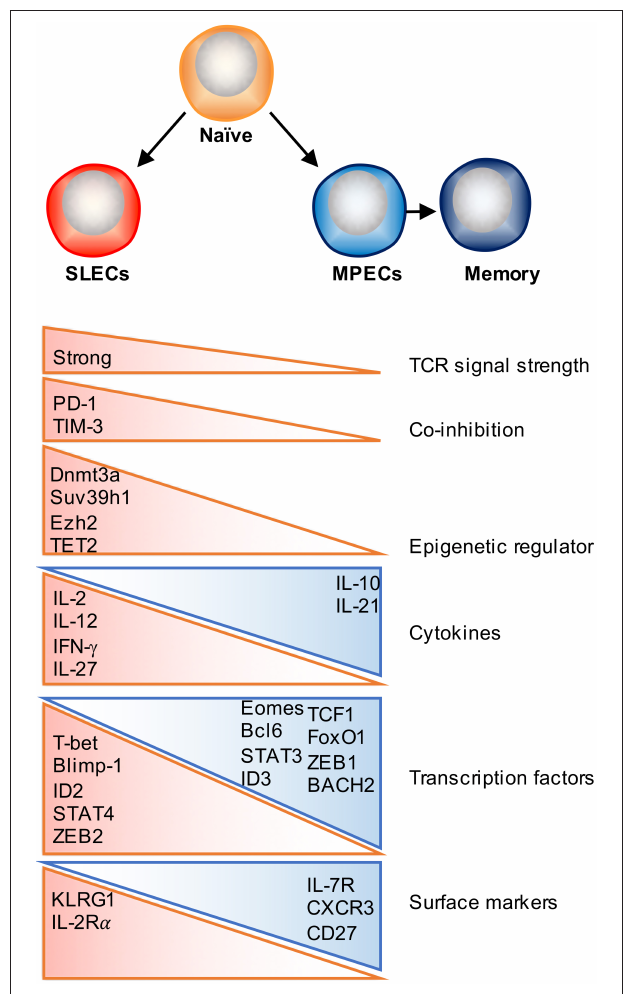
FIGURE 1 | Factors that regulate effector and memory cell fate decision. Following activation, antigen-specific naïve CD8T cells proliferate and differentiate into a heterogeneous pool of effector T cells that consist of two major subsets: SLECs and MPECs. Majority of SLECs die by apoptosis during contraction phase, whereas MPECs survive and become long-lived memory cells. Numerous factors as depicted can contribute to this cell fate decision process, which include TCR signal strength, co-stimulatory/co-inhibitory molecules, cytokines, transcription factors, and epigenetic